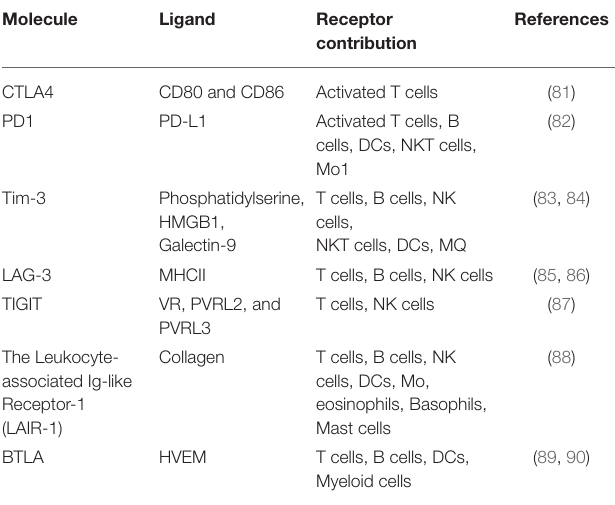
TABLE 1 | Co-inhibitory molecules which are supposed to be good candidates for targeting CAR T cells. Molecule Ligand Receptor